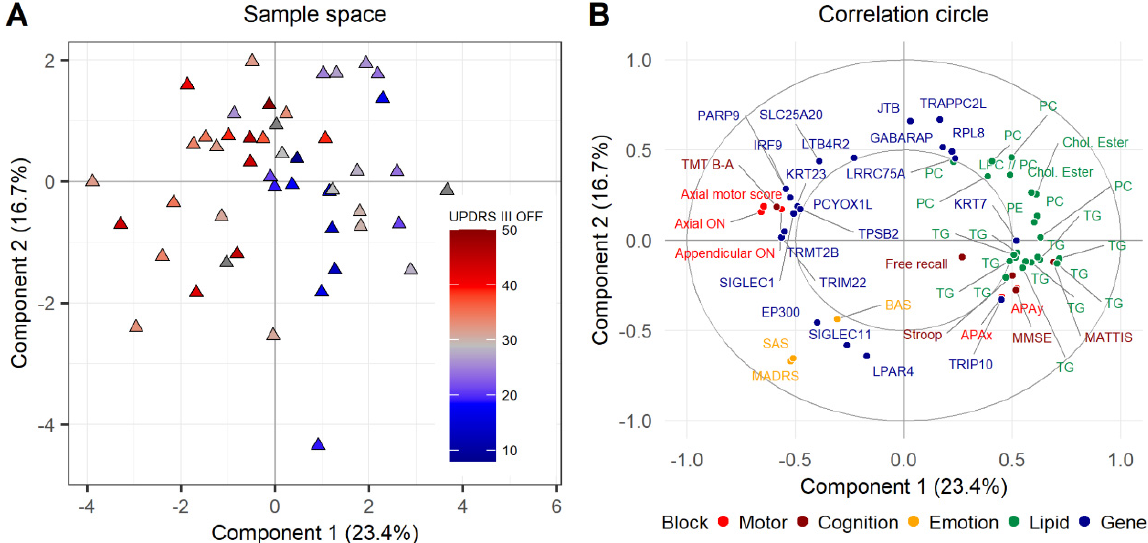
Figure 4. Sample space ( A ) and correlation circle ( B ) plots of the multimodal signature of lipids, genes and clinical features integrating the three clinical models (motor, cognition and emotion). The color gradient applied to the sample space indicates the increasing severity of motor impairment (UPDRS-III OFF) of PD patients. The top 10 relevant lipids are represented in green, genes in blue and clinical features in red. The percentages of variance on the components are indicated in parentheses.